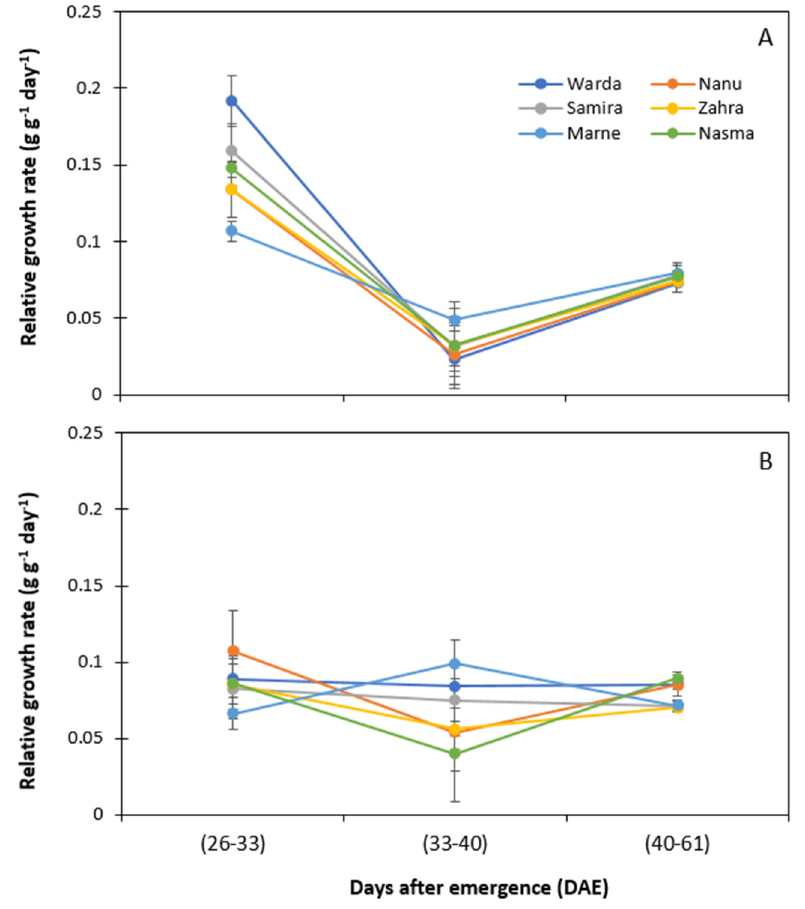
Figure 3. The relative growth rate (RGR) over time, days after emergence (DAE) of six cultivars of faba bean grown at Narrabri, NSW ( A ) and Toowoomba, QLD ( B ) in 2018 (LSD Narrabri: 0.035; Toowoomba: 0.046).